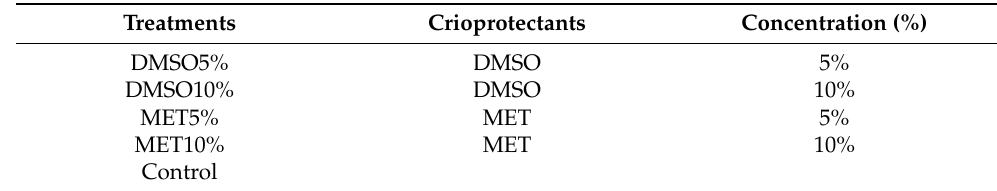
Table 1. Cryoprotectors evaluated in the cryopreservation of the microalgae Scenedesmus sp. DMSO, dimethyl sulfoxide; MET, methanol; without cryoprotectant